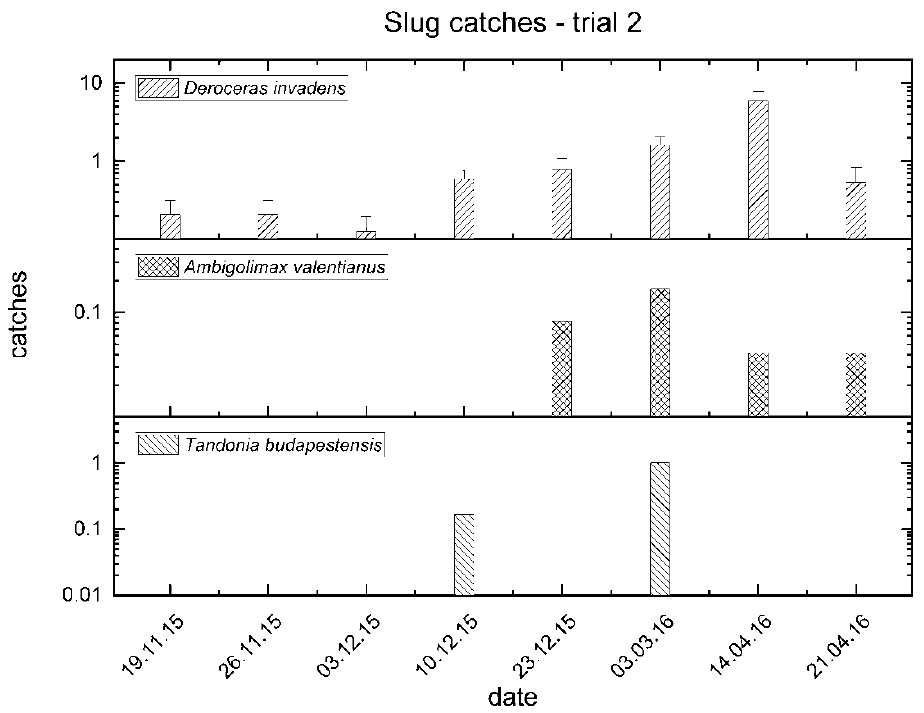
Figure 3. Mean catches of slugs between November 2015 and April 2016 in trial no. 2.